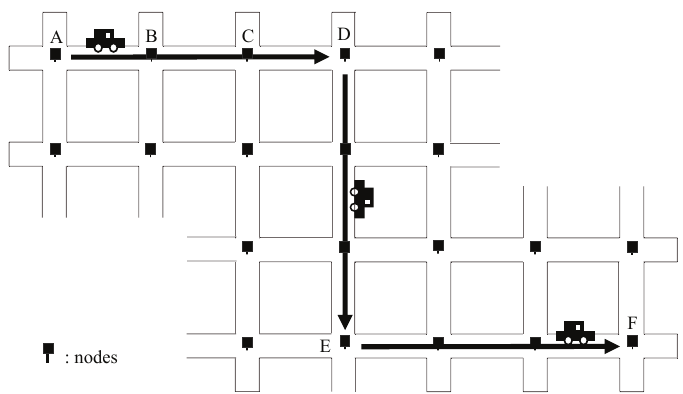
Figure 1. Definitions of Distance Units: The unit hop represents the number of static nodes on the path. The unit carry represents the number of vehicles required to forward packets on the